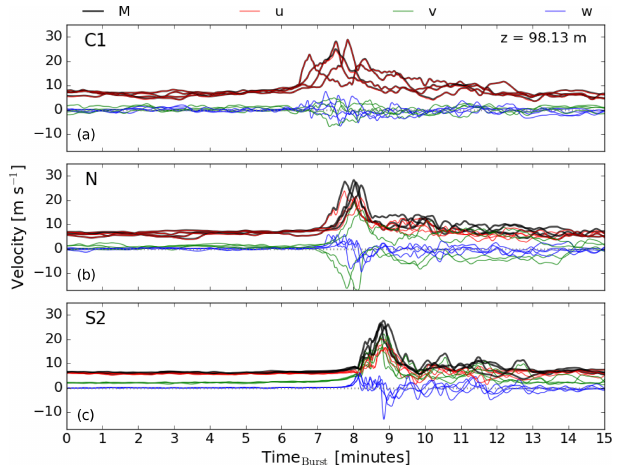
Figure 7. Time series of the velocity components at the location ( x = 6km, y = y max , z = 98 . 13m) for the C1 (a) , N (b) , and S2 (c) cases at the 6.0km cross section (red dashed line in Fig.